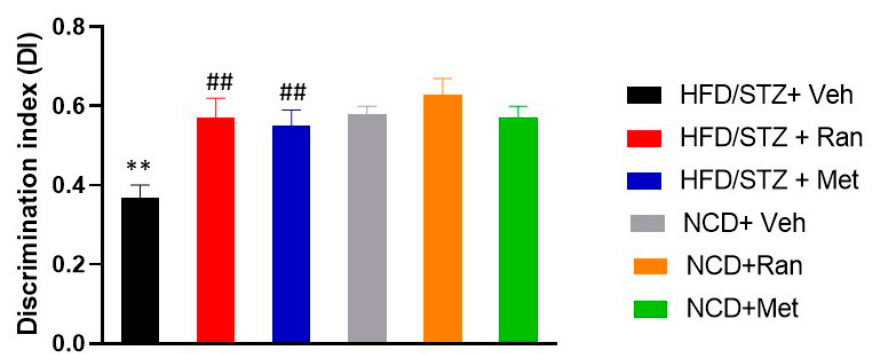
Figure 6. novel Object recognition test (nORT). Bars indicate the Discrimination Index (s). Data values are means ± SEM. ** p < 0.01 significantly di ff erent from NCD / STZ vehicle group. ## p < 0.01 significantly di ff erent from HFD / STZ vehicle group by two-way ANOVA with Tukey’s post hoc test. NCD = Normocaloric diet; STZ = Streptozotocin; Veh = Vehicle; HFD = High fat diet; Ran = Ranolazine; Met = Metformin.